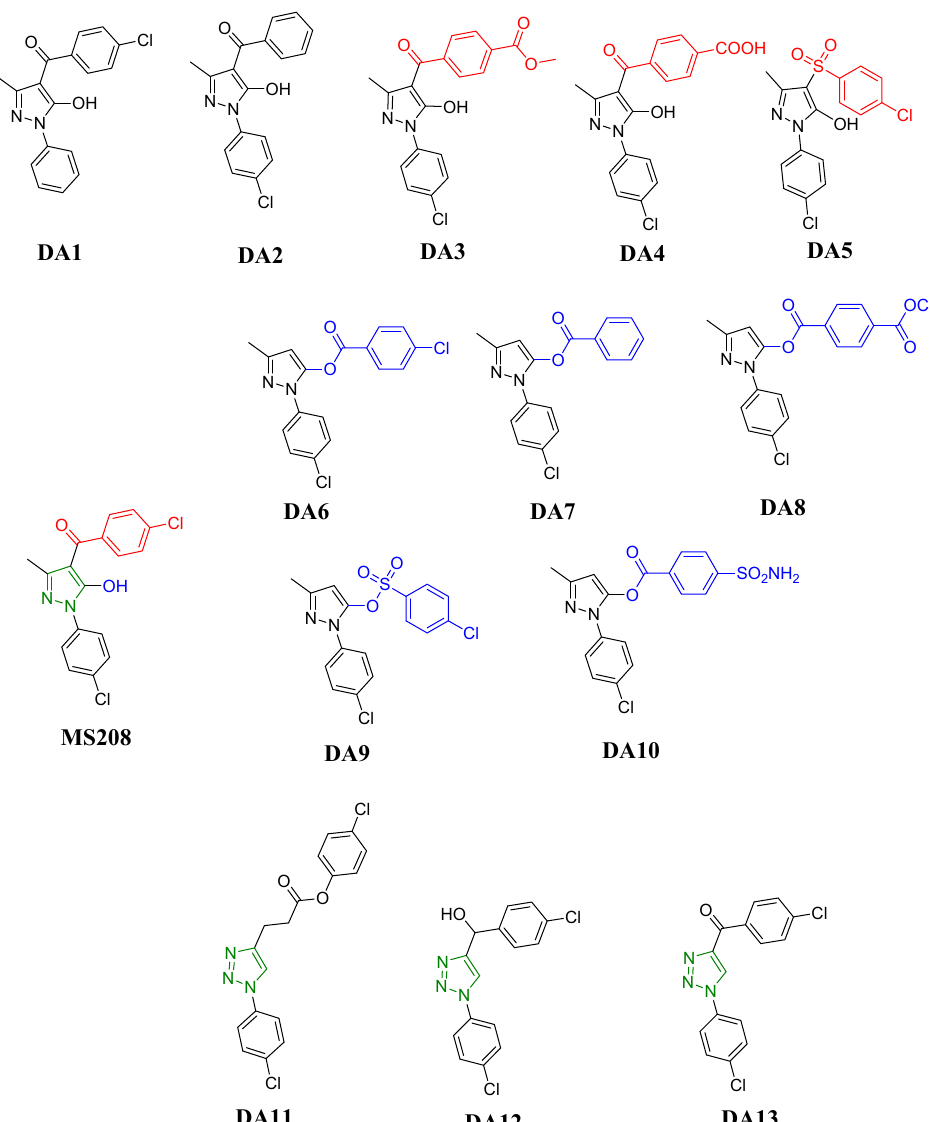
Figure 2. Chemical structures of targeted compounds DA1 – DA13 . C -acylated pyrazole series included DA1 – DA5 , O -acylated pyrazole series included DA6 – DA10 and triazolo series DA11 – DA13 Three novel analogues having a triazolo core, DA11 - DA13 (Figure 2), were designed